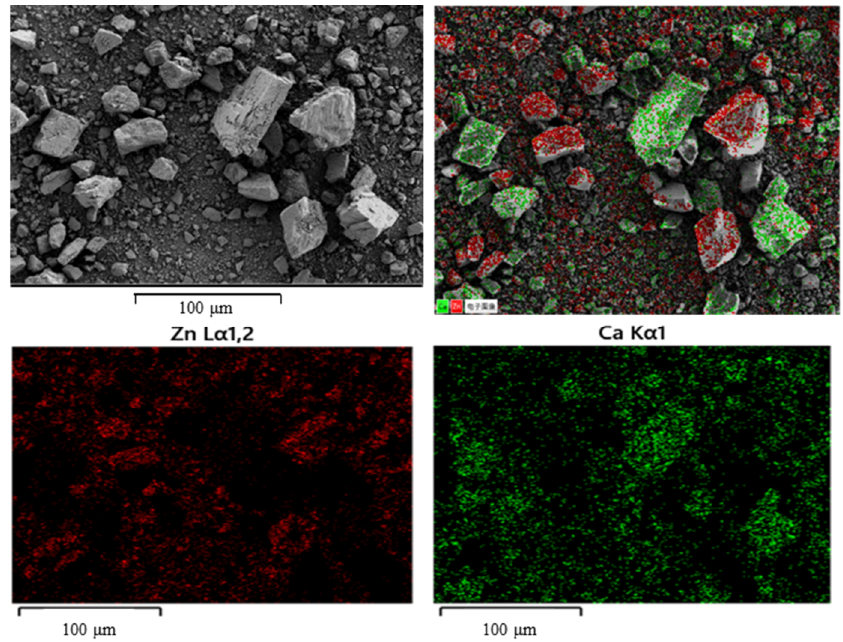
Figure 14. SEM-EDS pictures of flotation concentrate of the mixed mineral of smithsonite-calcite.